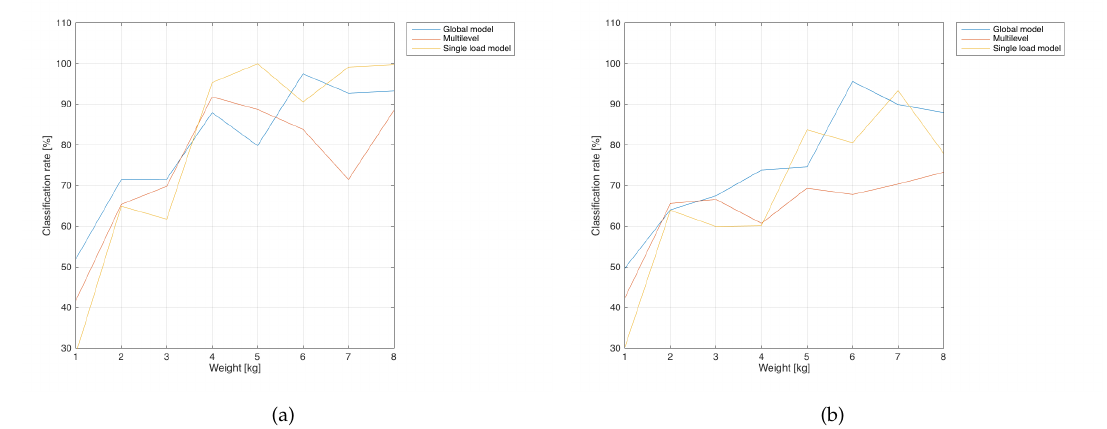
Figure 9. Performance of the proposed model with real weight ( a ) and estimated weight ( b